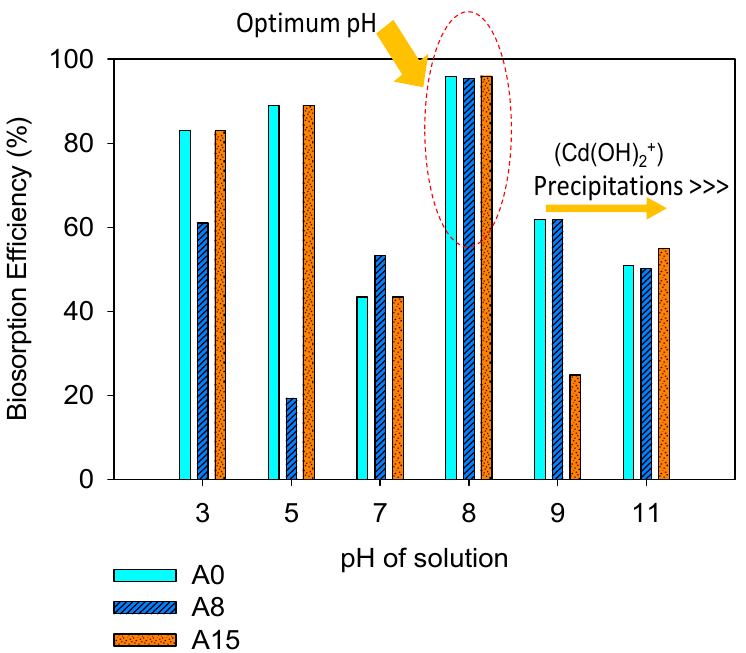
Figure 5. E ff ect of pH on sorption e ffi ciency of Cd 2 + onto dried biosorbent of Aphanothece sp. (W 0 = 0.1 g / L, C 0 = 1 mg / L, t contacts = 60 min, T = 30 ◦ C, pH = 8).